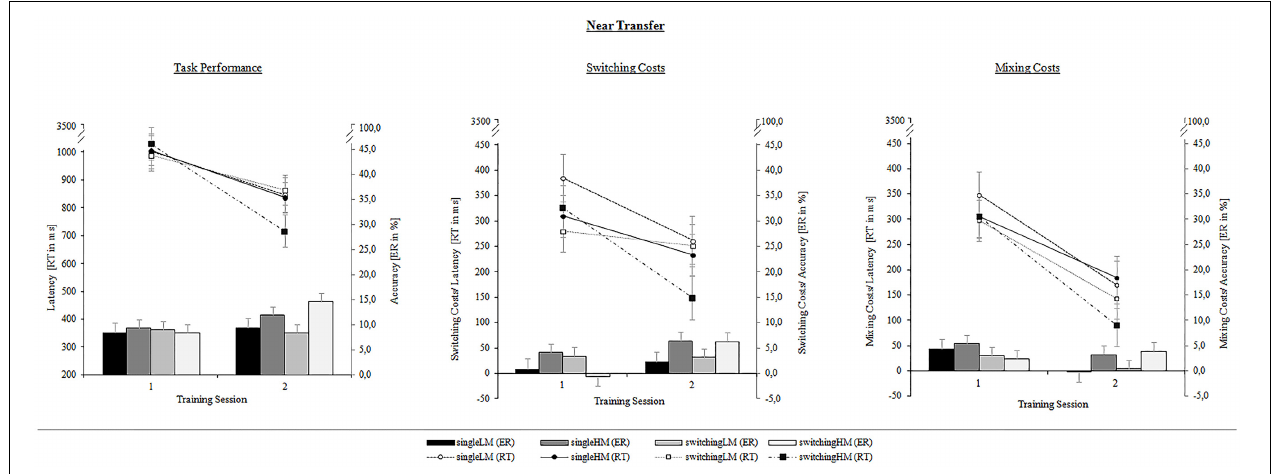
FIGURE 7 | Near-transfer performance on mean latencies (ms) and error rates (%) (left panel) as well as on the respective switching costs (middle panel) and mixing costs (right panel) as a function of Training Group (single-LM, single-HM, switching-LM, switching-HM) and Session